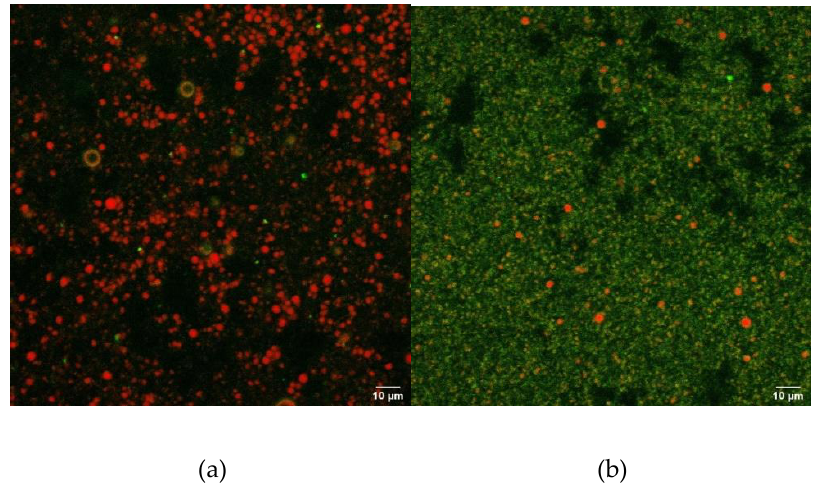
Figure 8. Images obtained by confocal laser scanning microscopy of emulsions containing control UF-retentate ( a ) and UF-retentate of plasma from pressure-treated granules ( b ) and targeted by Fast Green and Nile Red to observe proteins and fat, respectively.